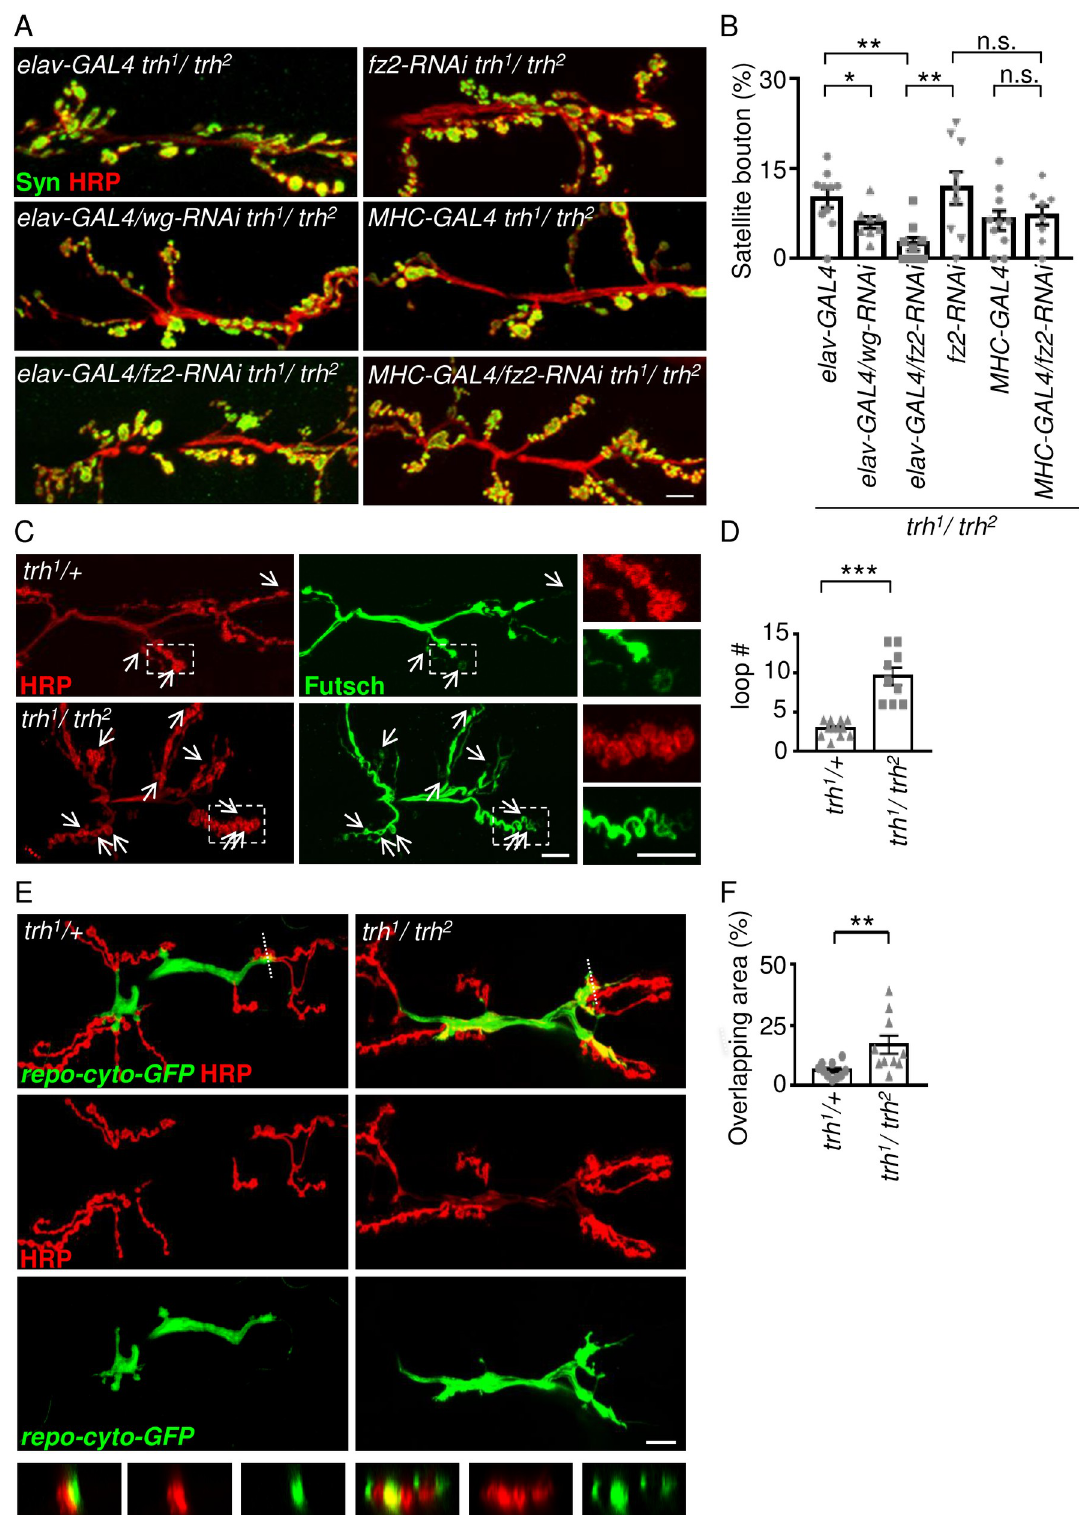
Fig 5. Presynaptic Wg signaling in modulating microtubule loops. (A) Images showing NMJ 6/7 immunostained for Syn (green) and HRP (red) in elav-GAL4 trh 1 /trh 2 , elav-GAL4/wg-RNAi trh 1 /trh 2 , elav-GAL4/fz2-RNAi trh 1 /trh 2 , fz2-RNAi trh 1 /trh 2 , MHC-GAL4